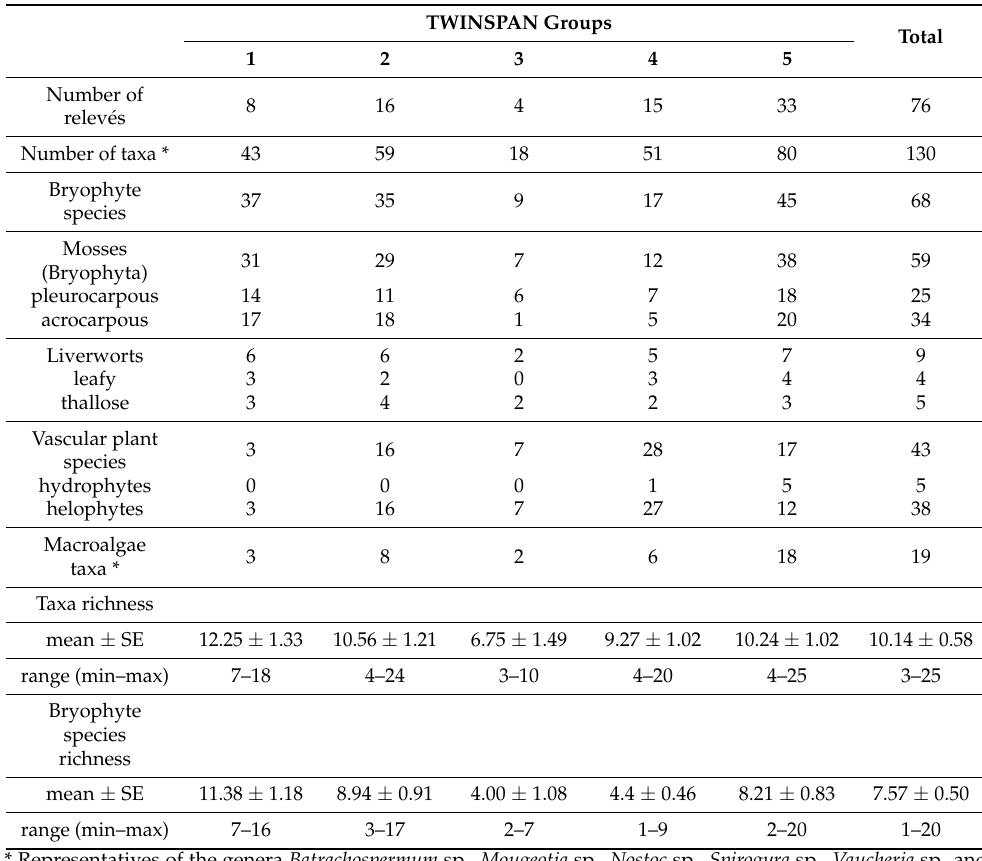
Table 3. Comparison of the number of taxa belonging to different macrophyte components and mean taxa and bryophyte species richness among TWINSPAN